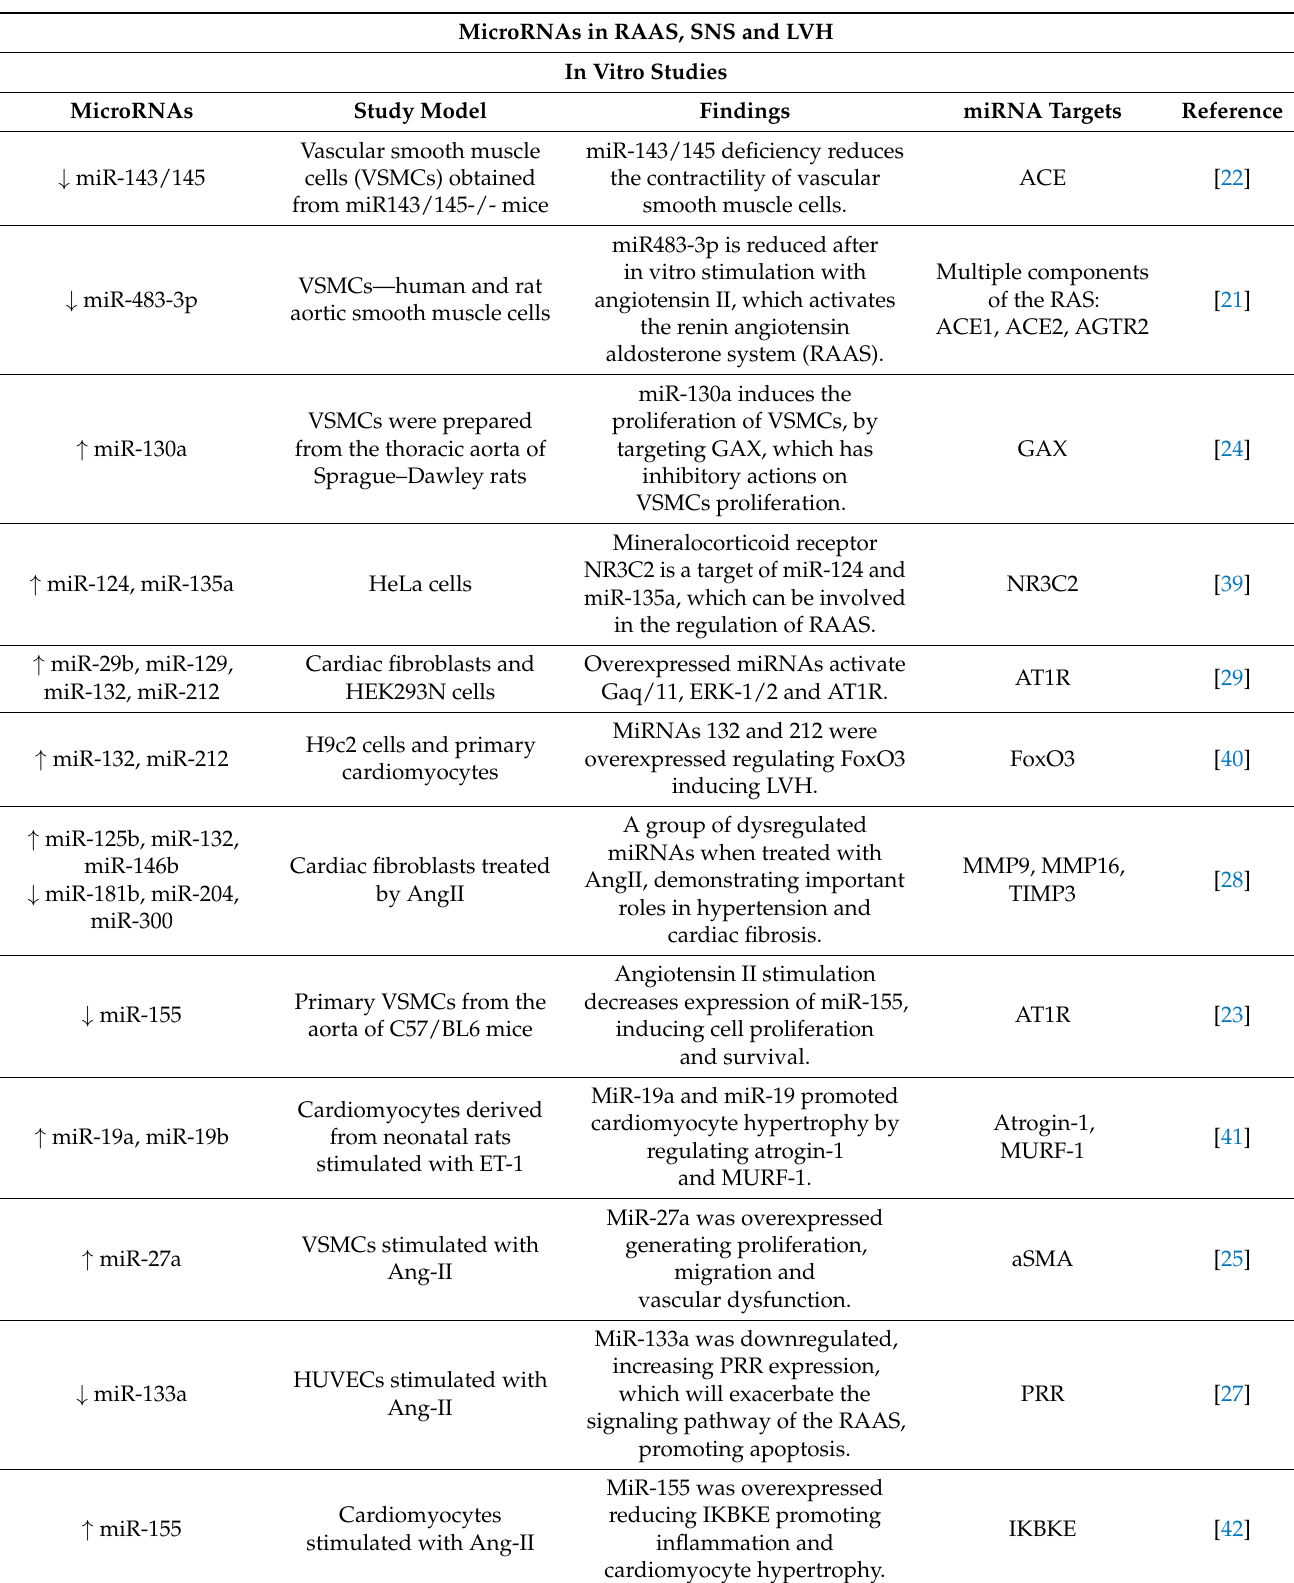
Table 1. Expression of miRNAs in RAAS, SNS and